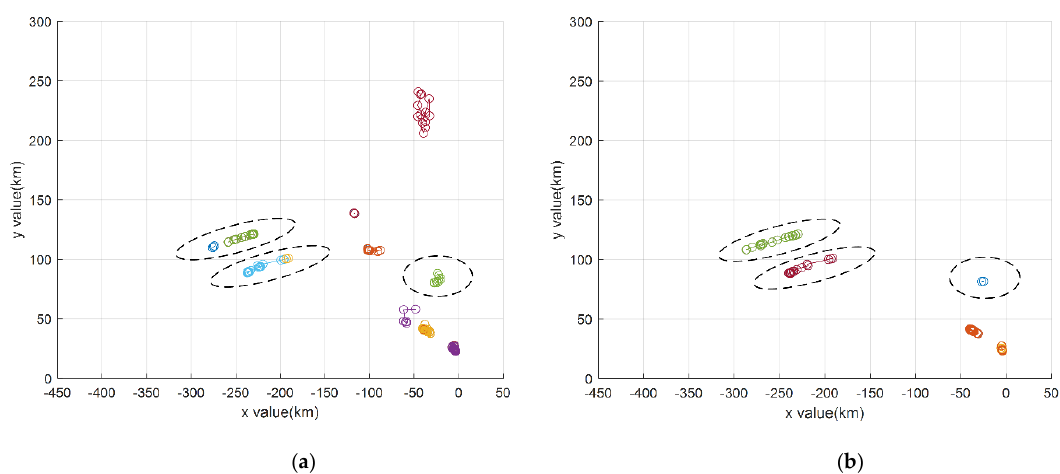
Figure 14. Tracing results of NN-MHT and MCSNG-NN: ( a ) NN-MHT tracing result; ( b ) MCSNG-NN tracing result. Table 7. The performance indexes of NN-MHT and MCSNG-NN.